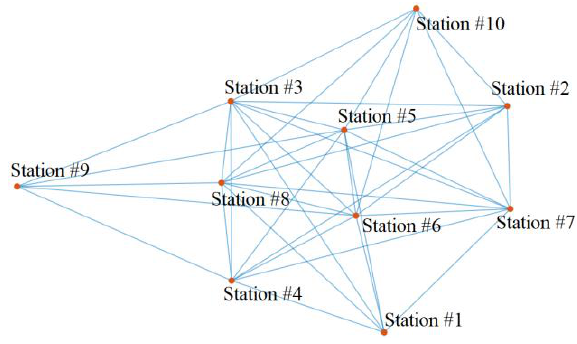
Figure 2. Graph presenting the connections between stations based on at least three tie points – example of a case study with 10 point clouds Figure 2 represents the graph that is generated for the test dataset presented in Section 4.1. In this example all the moving point clouds are linked to the reference, which is station